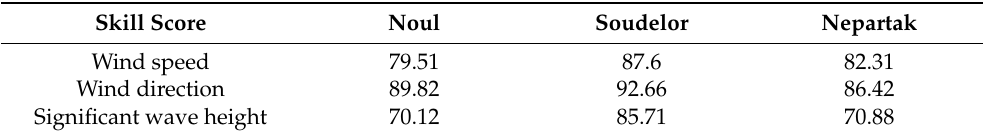
Table 17. Skill scores of the wind speed, wind direction, and signi fi cant wave height obtained from the best simulation experiments for typhoons Noul, Soudelor, and Nepartak.